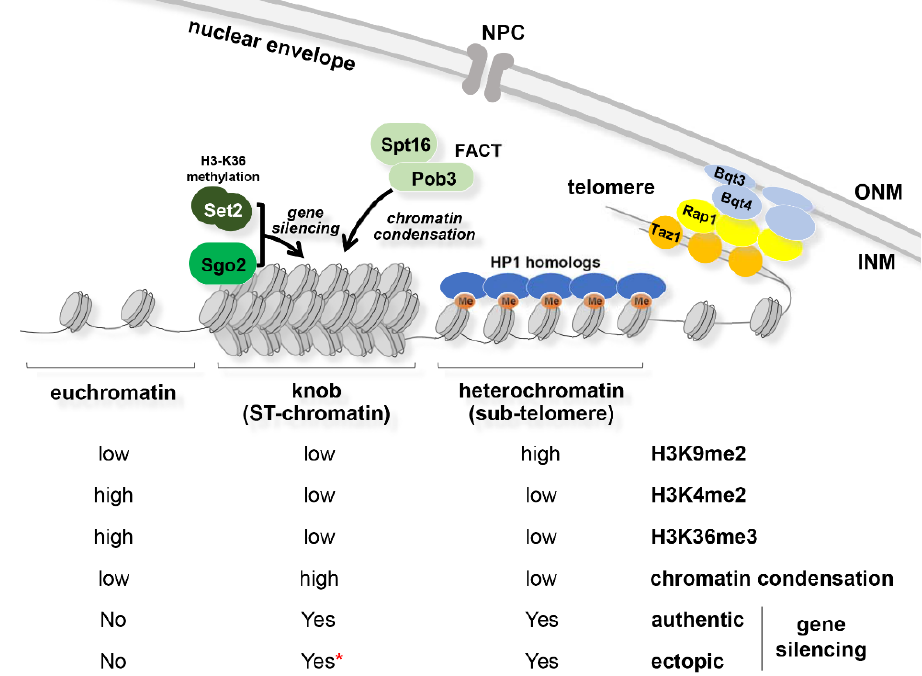
Figure 4. Chromatin states in telomeric regions. A highly condensed “knob” at ST-chromatin region formed by a cooperative action of Sgo2 and Set2, and a FACT-dependent nucleosome assembly pathway. (Lower columns) Levels of histone modifications (H3K9me2, H3K4me2, and H3K36me3). Levels of chromatin condensation. Gene silencing: “authentic”, expression of endogenous genes upon nitrogen starvation; “ectopic”, expression of the ura4 + reporter gene ectopically inserted; * silencing in the knob region depends on the position of ura4 + insertion.